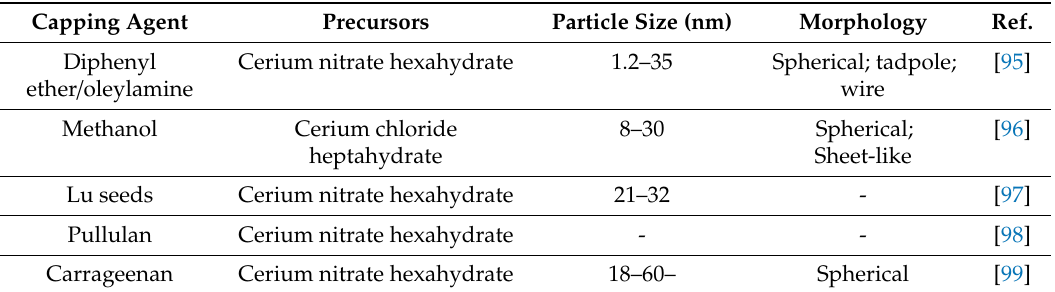
Table 6. Table showing the synthesis of cerium oxide nanoparticles using the solvothermal